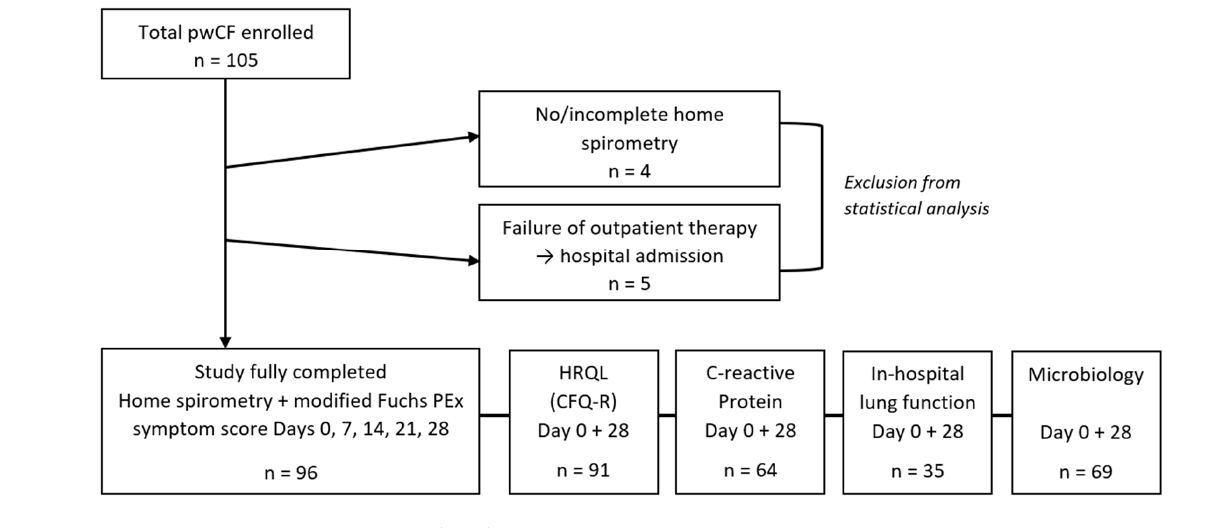
Figure 1. Study cohort. Table 1. Baseline Data (Day